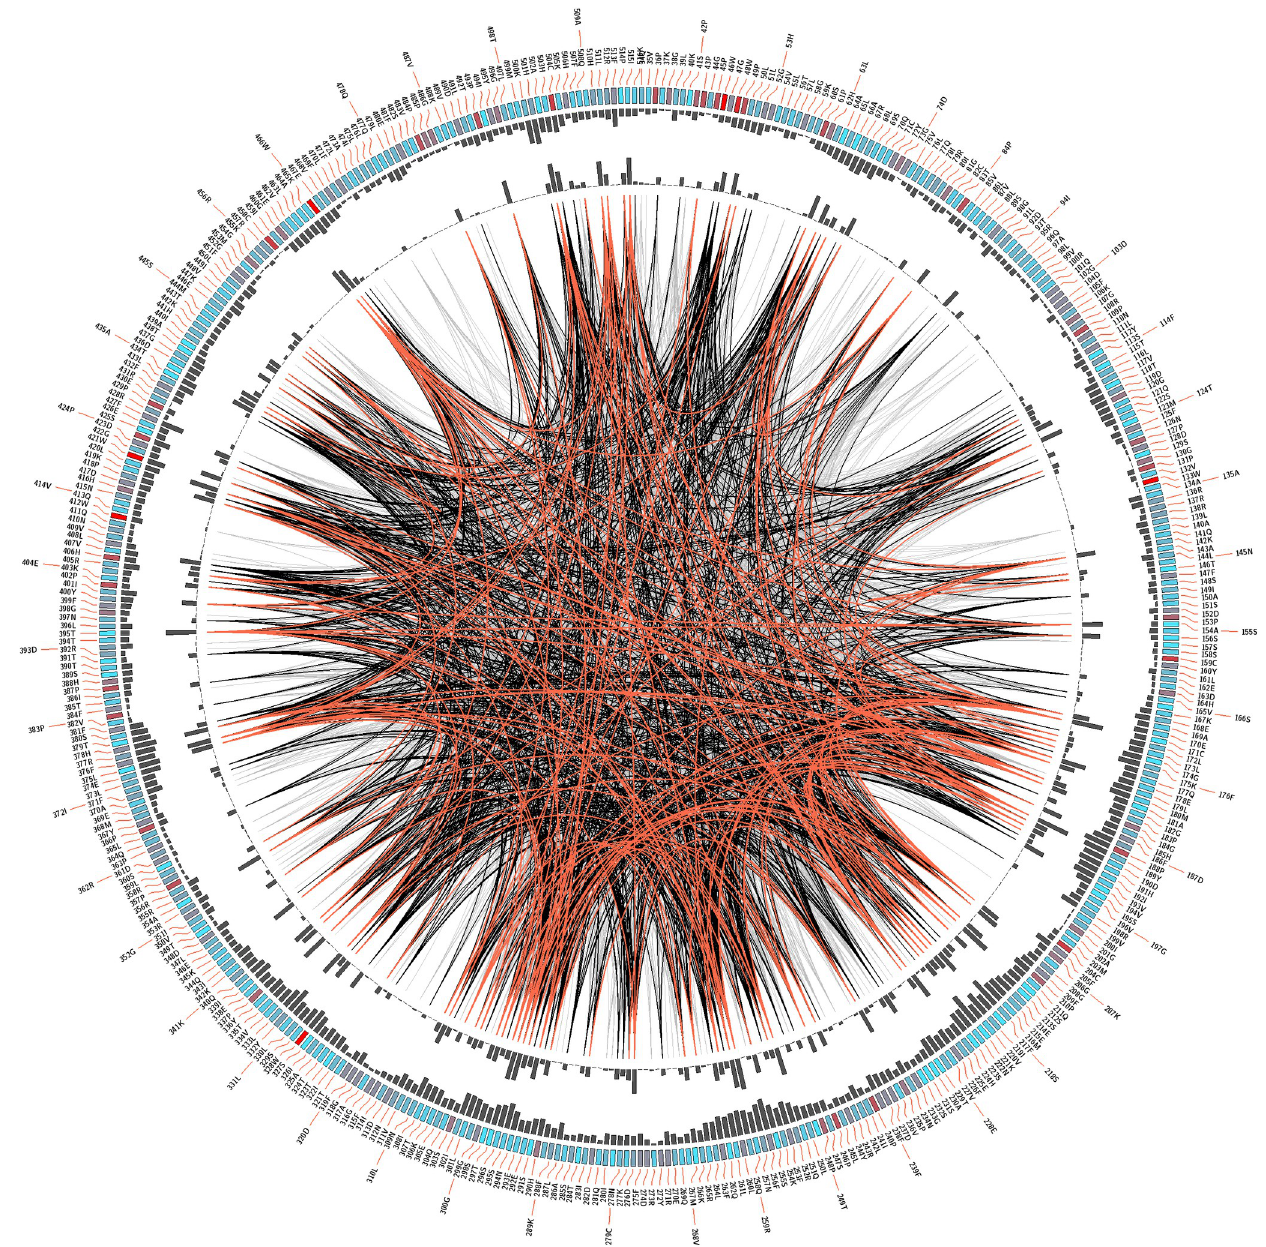
Fig 1. CIRCOS analysis of CYP1A2 i.e., interspecies alignment of the enzyme sequence.